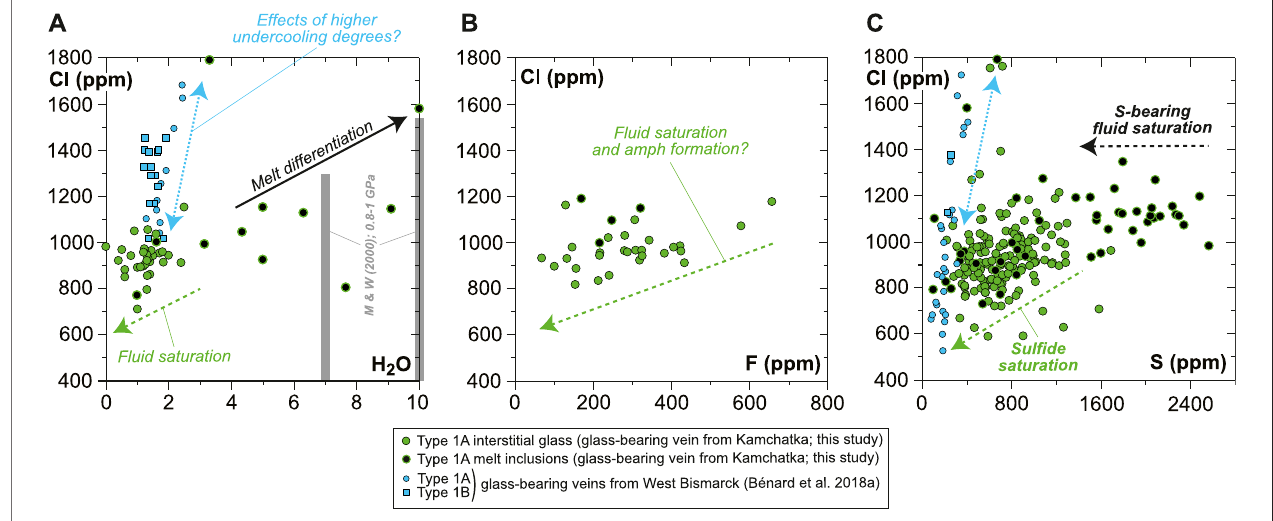
FIGURE 10 | Plots showing the volatile (H 2 O, F, Cl, and S) compositional relationships for the MIs and interstitial glass in the new Kamchatka vein in this study (normalized on an anhydrous basis). (A,C) Average data acquired using a sample current of 20 nA and (B) average data acquired using a sample current of 40 nA ( Supplementary Table S1 ). Also shown in (A) are literature data for H 2 O solubility limits in haploandesite melts at 0.8 – 1 GPa (two gray bars for 1,000 ° C and 1,100 ° C; Mysen and Wheeler,